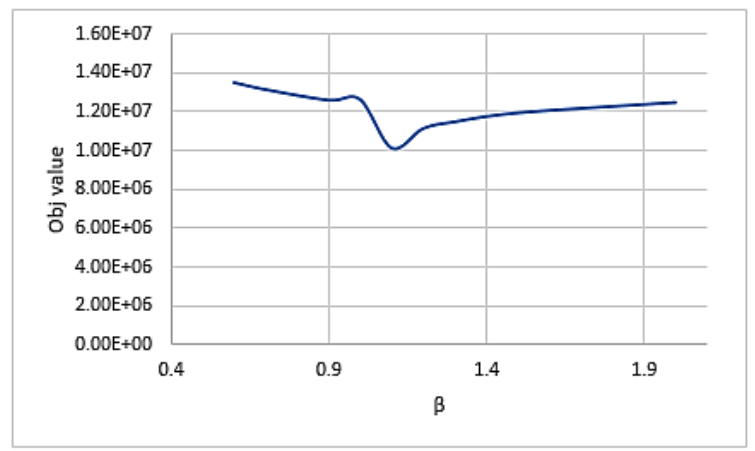
Fig. 4. Value changes based on changes in capacity.